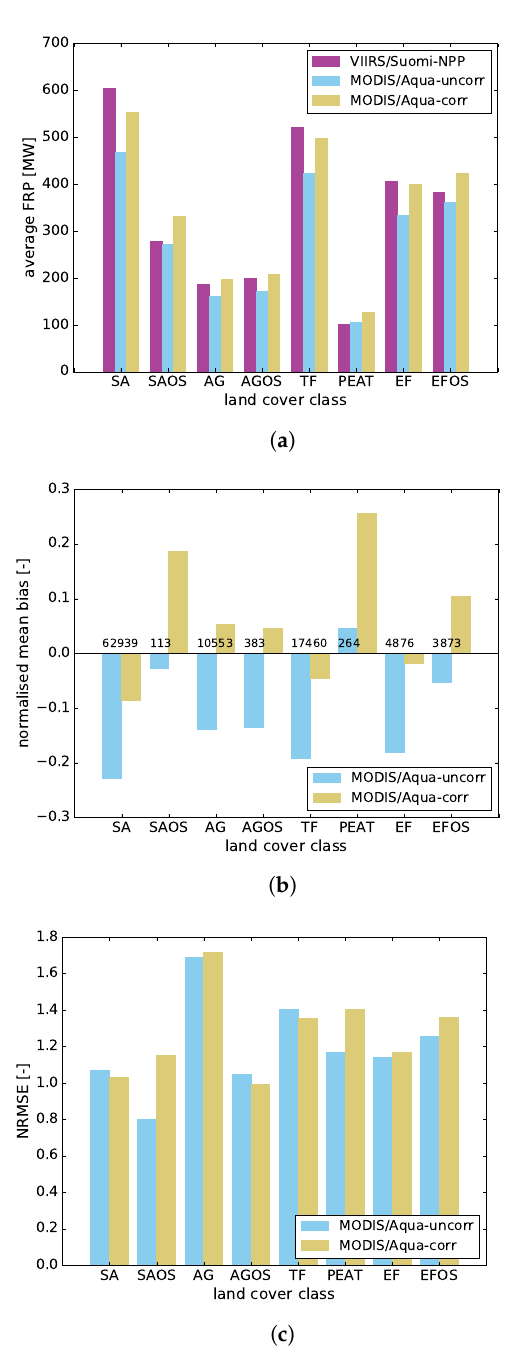
Figure 5. Statistics between co-located MODIS/Aqua and VIIRS/Suomi-NPP gridded-FRP observations (hourly, 2017) with and without correction, and classified according to the land cover type. ( a ) The average gridded-FRP of MODIS and VIIRS co-located pairs; ( b ) the normalized mean bias between MODIS and VIIRS co-locations. The number of co-locations for each landcover class are mentioned near the zero-bias line; ( c ) the normalized root mean square error (NRMSE) between the co-located pairs. The co-location pairs with MODIS viewing angle greater than 55 ◦ are excluded in these statistics. The labels “corr” and “uncorr” refer to MODIS/Aqua gridded-FRP observations with and without bias correction. The land cover classes used to aggregate the VIIRS/Suomi-NPP and MODIS/Aqua FRP co-location pairs, for comparison according to the fire type: savanna (SA), savanna with organic soil (SAOS), agriculture (AG), agriculture with organic soil (AGOS), tropical forest (TF), peat (PEAT), extra-tropical forest (EF), and extra-tropical forest with organic soil (EFOS)